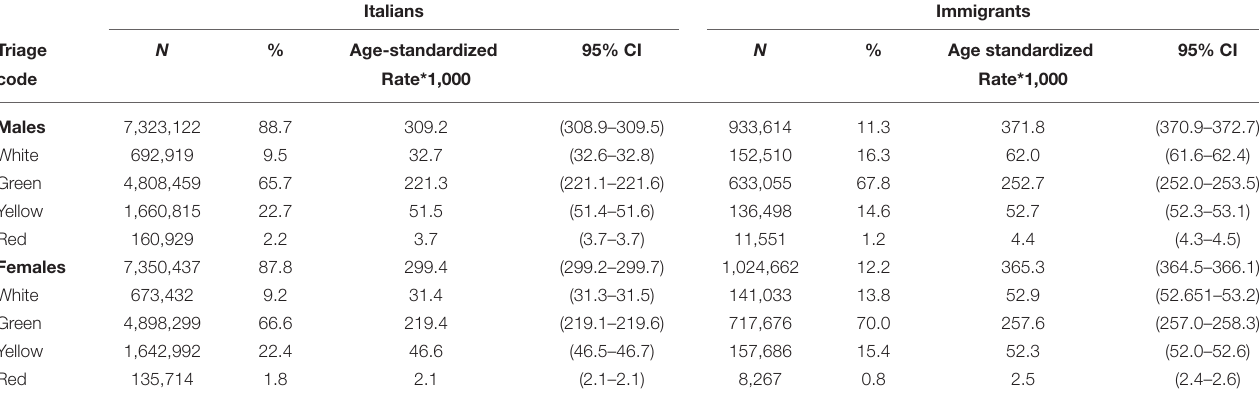
TABLE 3 | Emergency care access: proportions and age-standardized rates per 1,000 residents, by triage code, sex, and citizenship ( < 65 years).